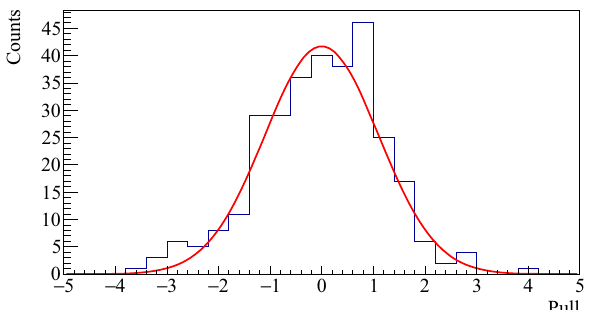
Fig. 7 Pull distribution obtained from the reference fit residuals of all bins. The Gaussian fit to the pull distribution gives μ = 0 . 00 ± 0 . 07 and σ = 1 . 11 ± 0 . 06, with χ 2 /dof = 18.4/15